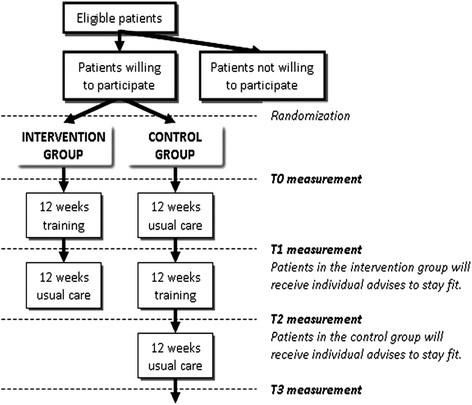
Flow diagram of the study design.